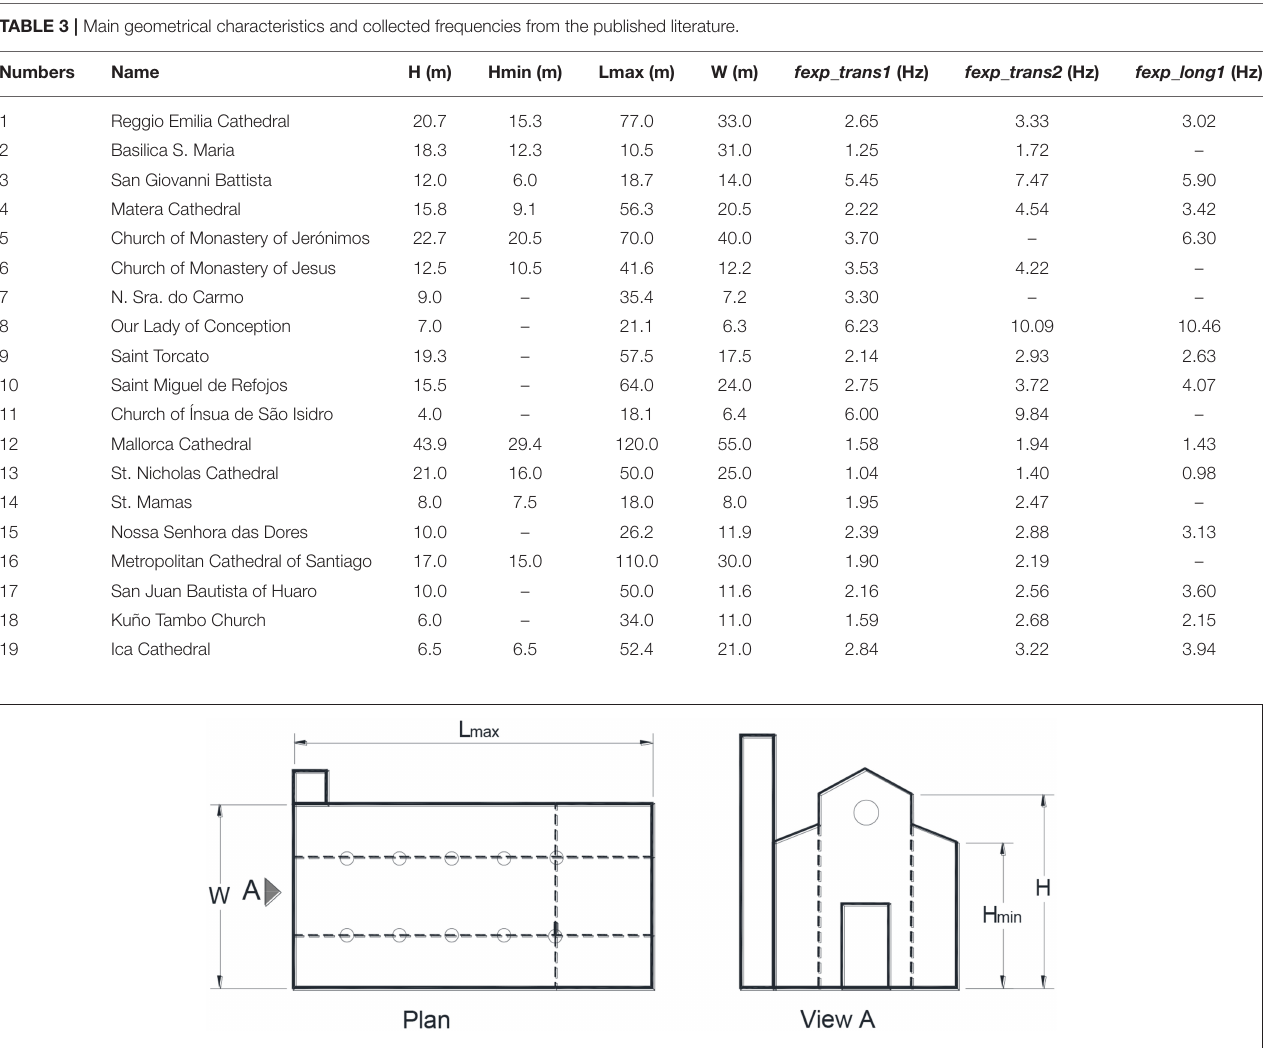
FIGURE 7 | Main geometric features of the churches in plan and frontal view.